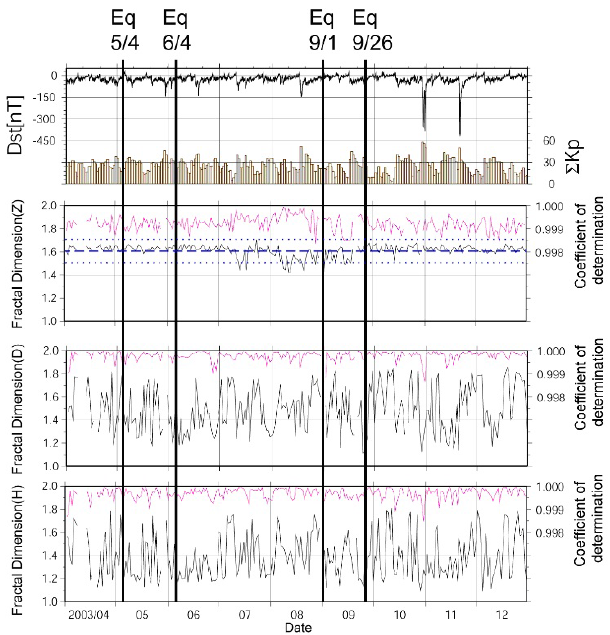
Fig. 3. The same as Fig. 2, but for a limited time period of April to December 2003, in order to find the fractal change for several